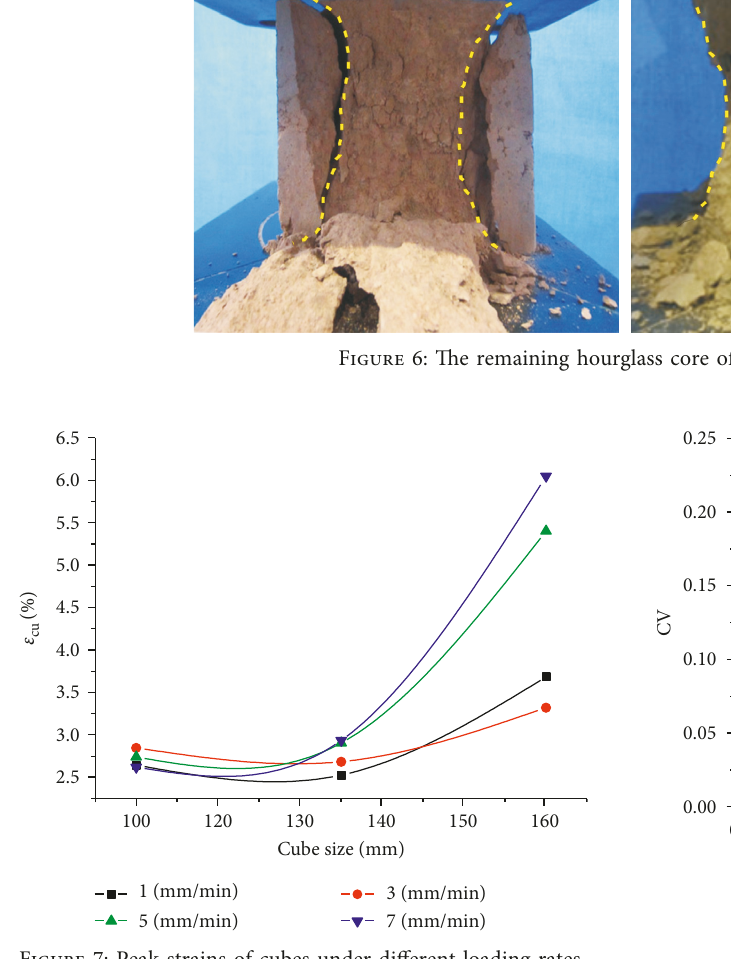
Figure 8: CV of compressive